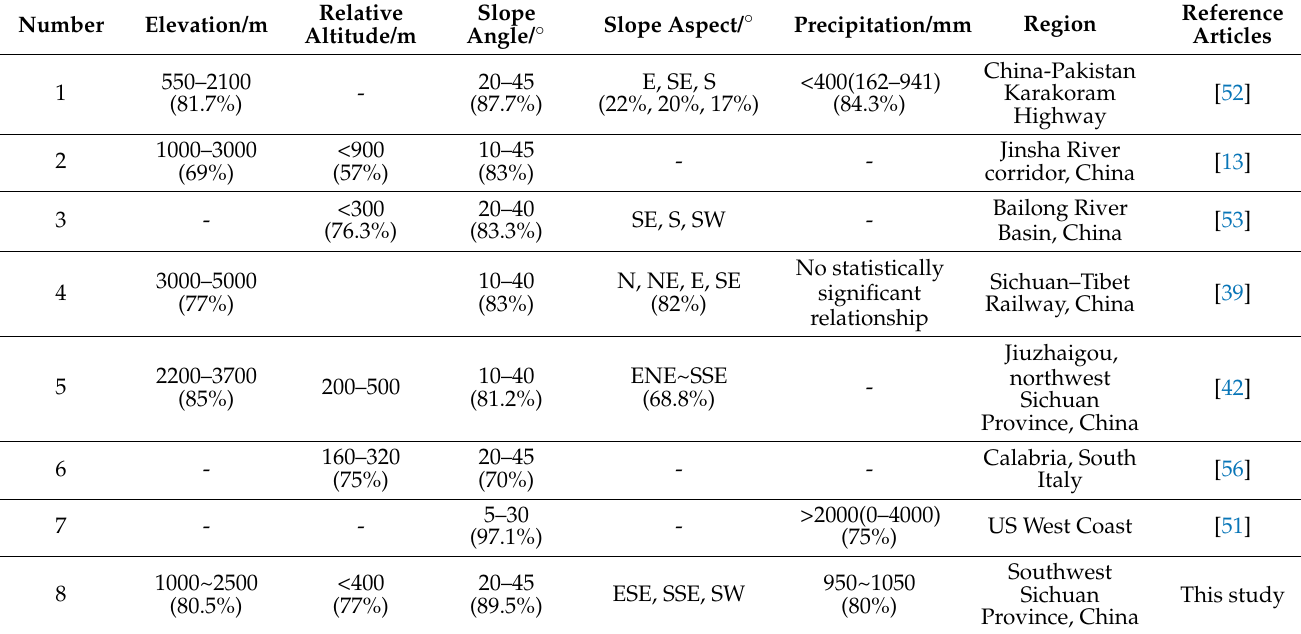
Table 4. Statistics on the spatial distribution of detected landslides in other